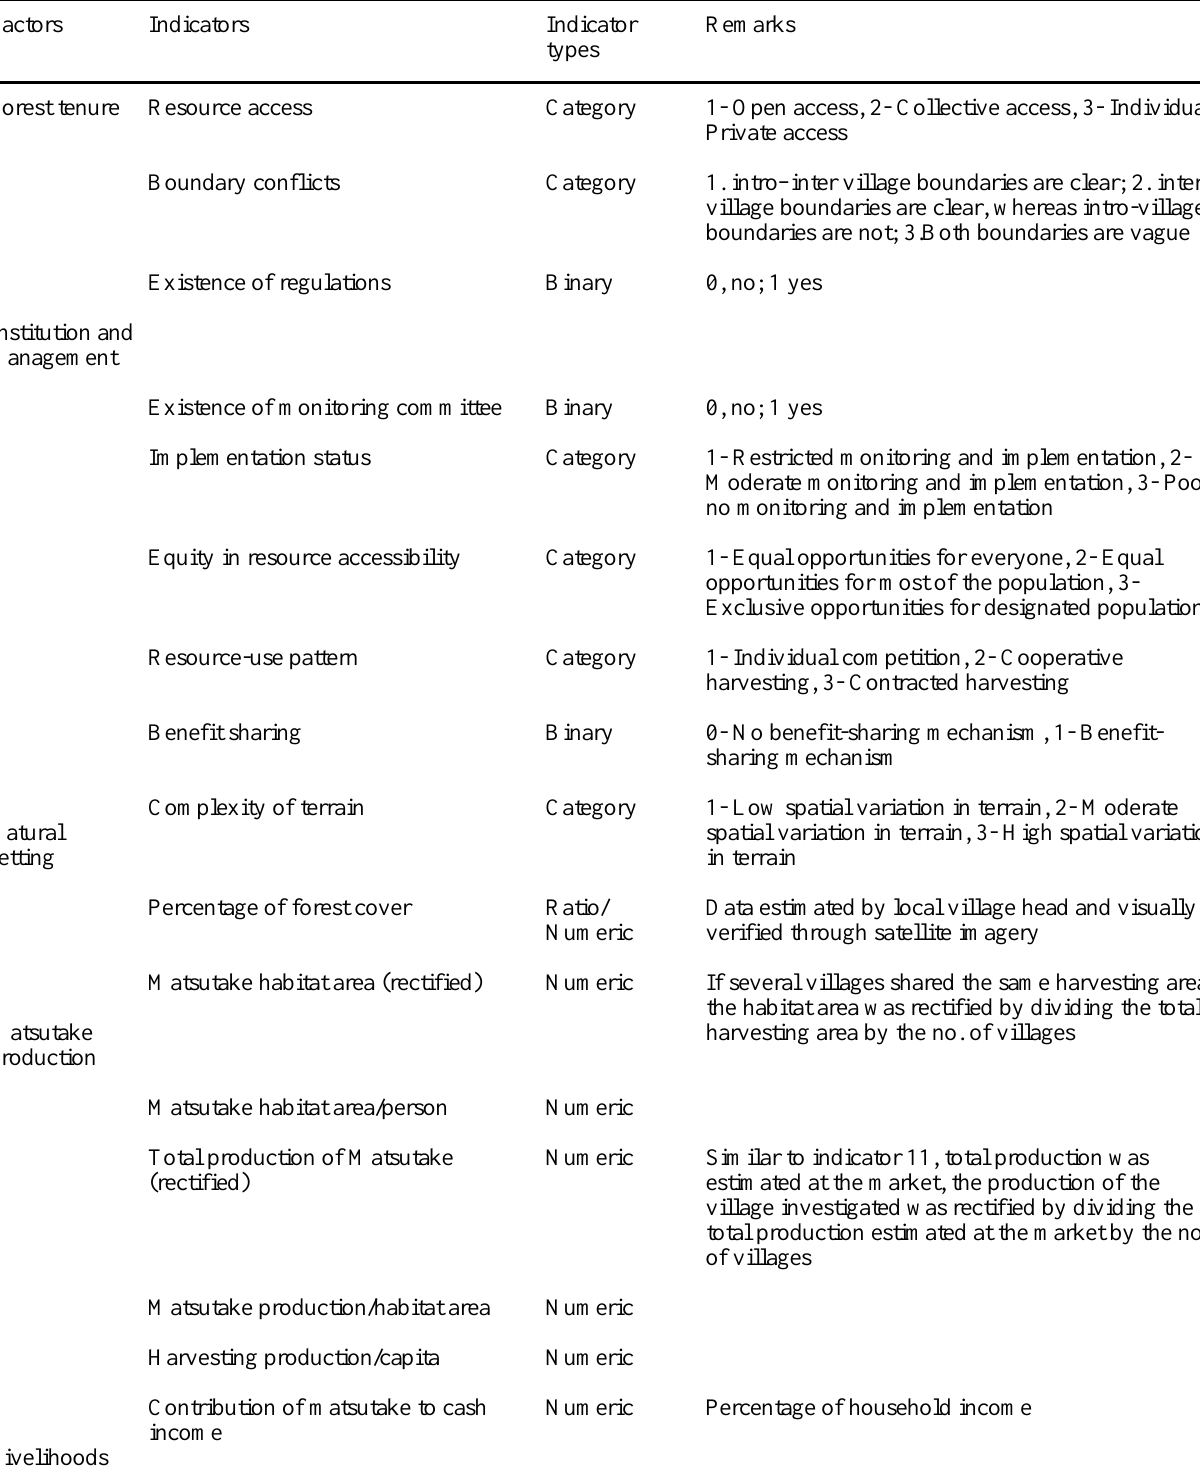
Table 3. Factors used for clustering management